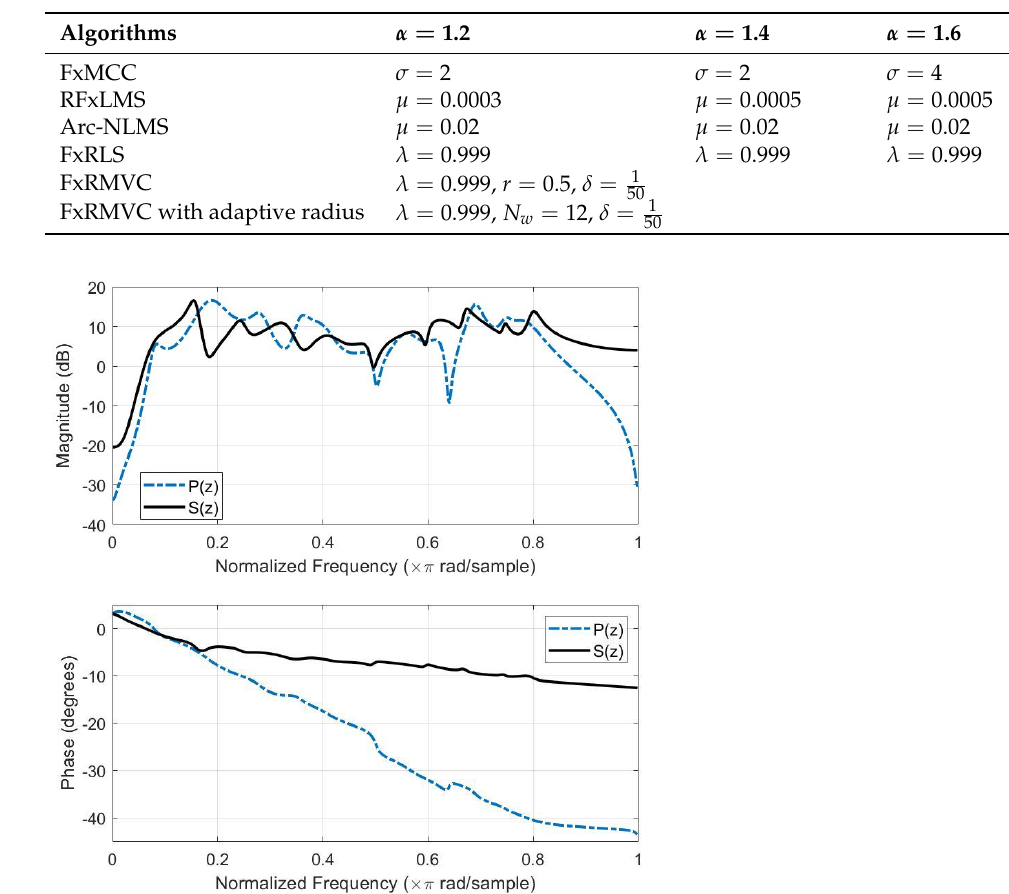
Table 3. The parameters in algorithms.